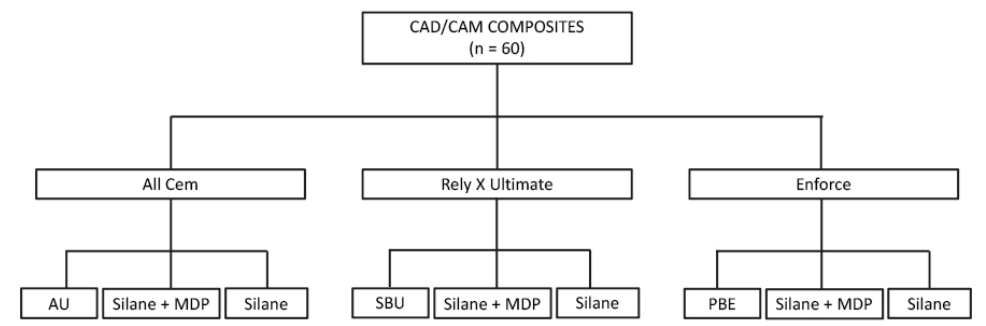
Figure 1. Experimental design carried out for this study. Table 2. Description of the materials, manufacturers, compositions, application method, and indi- cation of the materials used in this study.